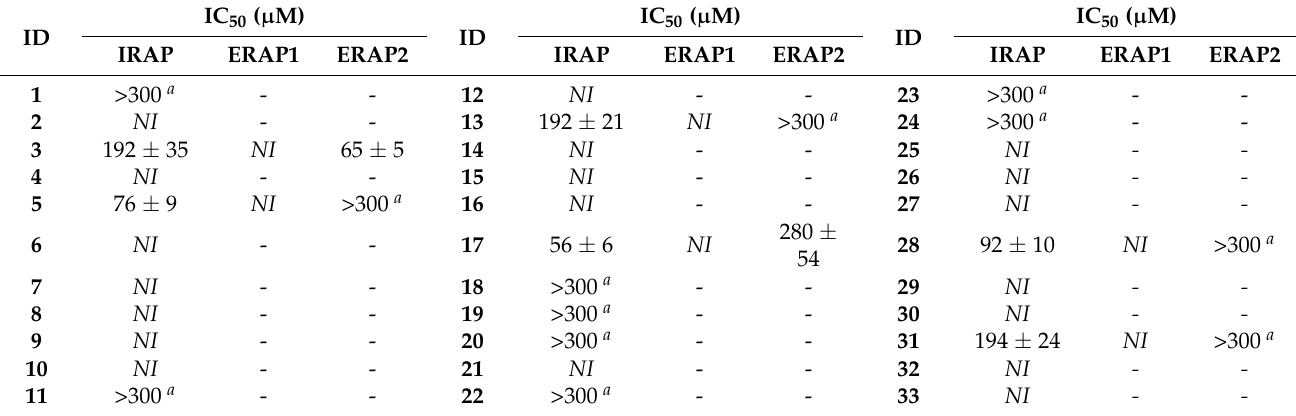
Table 2. IC 50 values for compounds 1 – 33 calculated from the small fluorogenic substrate